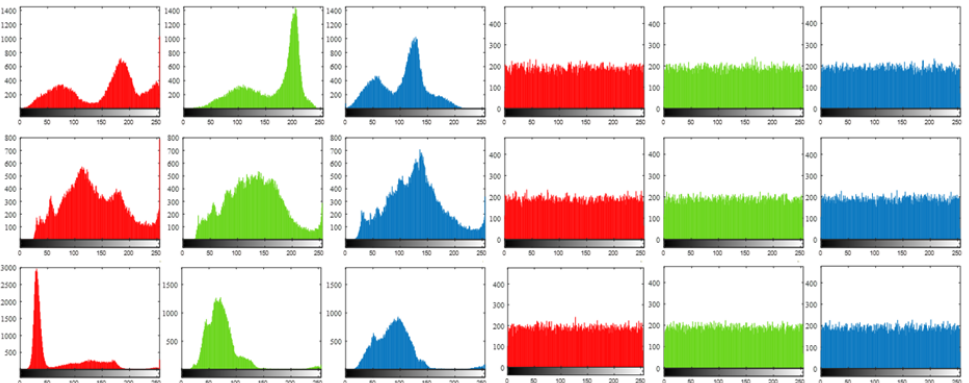
Figure 7. The first, second, and third columns show the histograms of pixel distribution that are calculated based on pixels from red, green, and blue channels of original RGB images that are named llama, car, and football, respectively. Correspondingly, the fourth, fifth, and sixth columns show the histograms of pixel distribution that are calculated based on pixels from signal Y c . The compression rate is